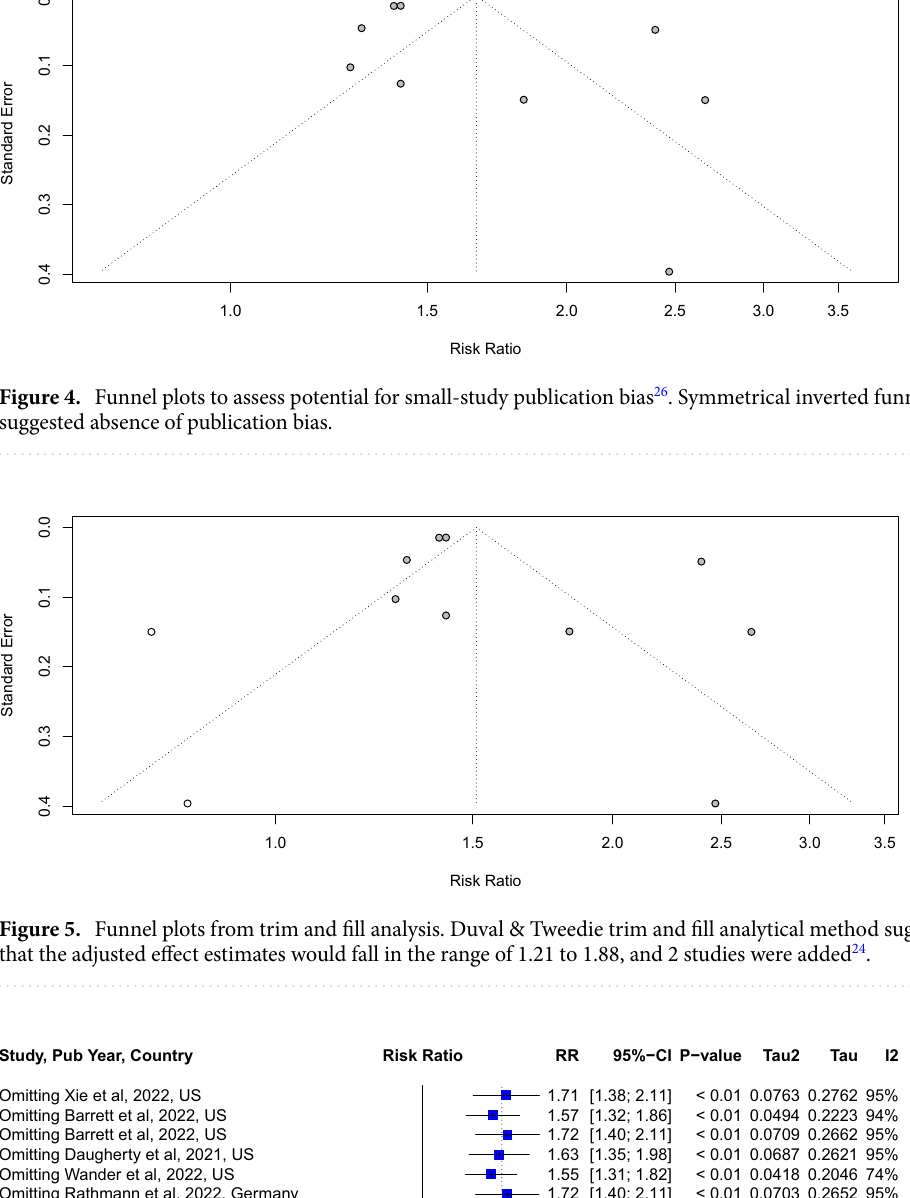
Study, Pub Year, Country